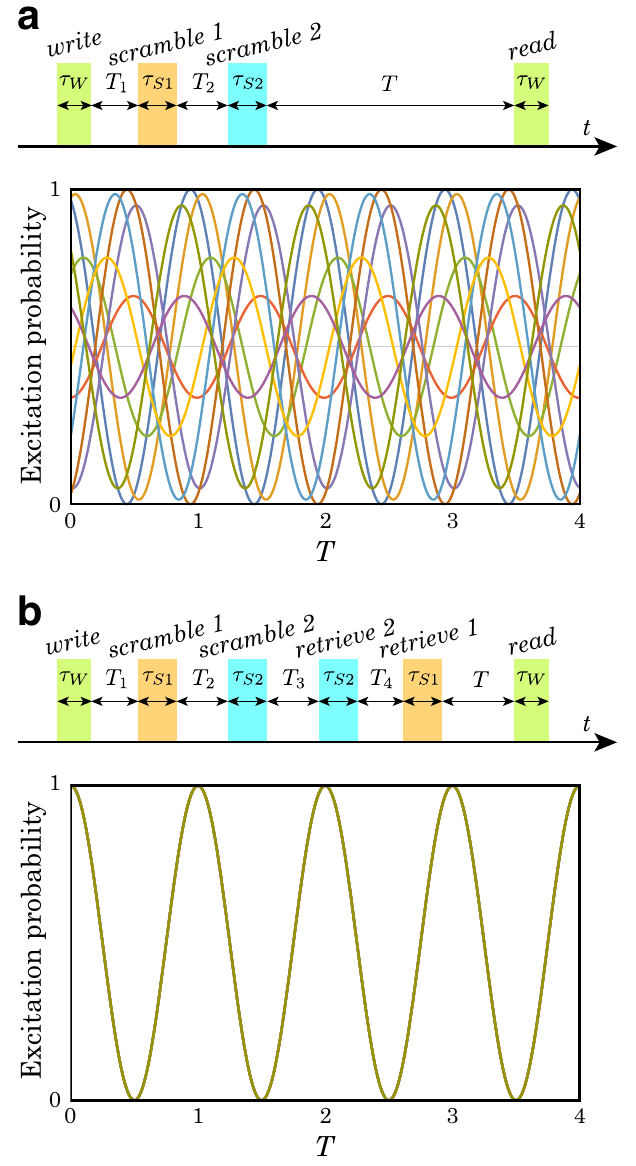
Figure 4. Double scrambling encryption and decryption. The horizontal axis T of the plot in ( a ) and ( b ) is normalized with 2 π / δ j . The excitation probability includes several curves calculated with a phase difference ∈ [0, 2 π ] and φ = π /15. ( a ) Double scrambling pulse sequence and calculated excitation probability. The φ S 1 S 2 phase ambiguity of excitation probability is expanded to ~2 π with the double scrambling and it is completely impossible to determine the quantum phase. ( b ) Retrieve sequence for the double scrambling encryption and the excitation probability. The retrieve -1 pulse for the scramble -1 pulse comes after the retrieve -2 pulse for the scramble -2 pulse. The pulse application time should satisfy T 2 + T 3 + T 4 + 2 τ S 2 = (2 m + 1) π / δ S 1 and T 3 = (2 n + 1) π / δ S 2 , where m and n are integers. The δ j , φ j , and τ j with j = S 1 or S 2 represents the detuning, phase difference, and pulse duration of the SRI-1 ( j = S 1) and SRI-2 ( j = S 2), respectively, and the T k with k = 1, 2, 3, and 4 represents the time interval between the write and scramble -1 pulses ( k = 1), the scramble -1 and scramble -2 pulses ( k = 2), the scramble -2 and retrieve -2 pulses ( k = 3), and the retrieve -2 and retrieve -1 pulses ( k = 4),